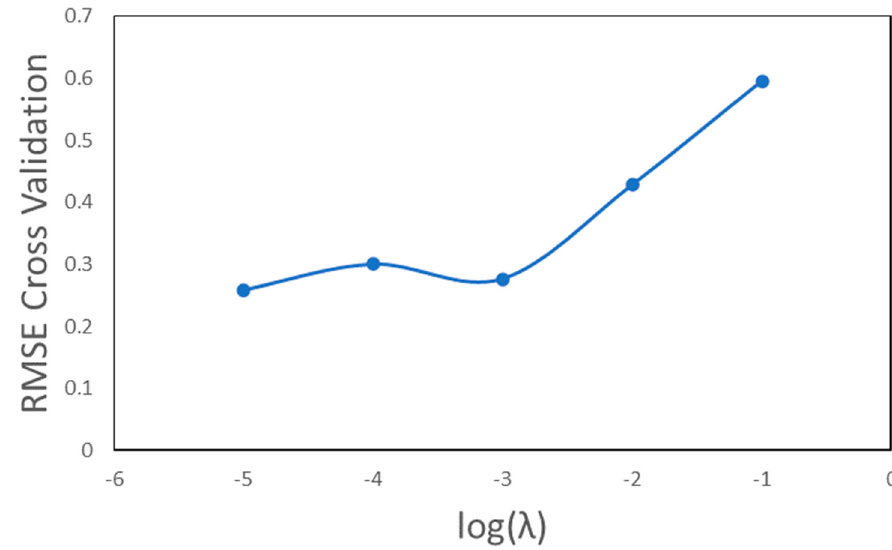
Figure 5. RMSE cross ‐ validation values for setting the number of perceptrons. It is set up to 15,575 distributed in 7 layers.